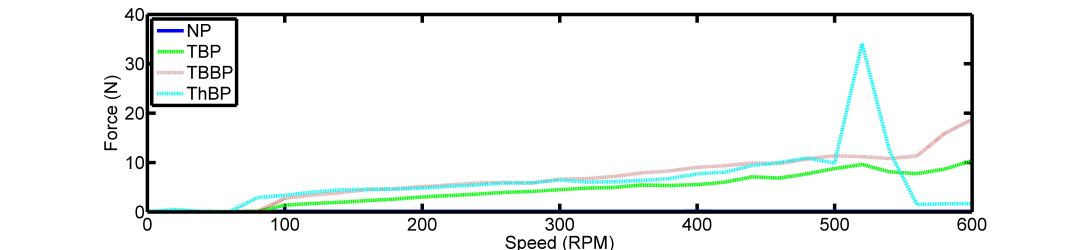
Figure 7. The RMS values of the time signatures captured for all speeds for each propeller